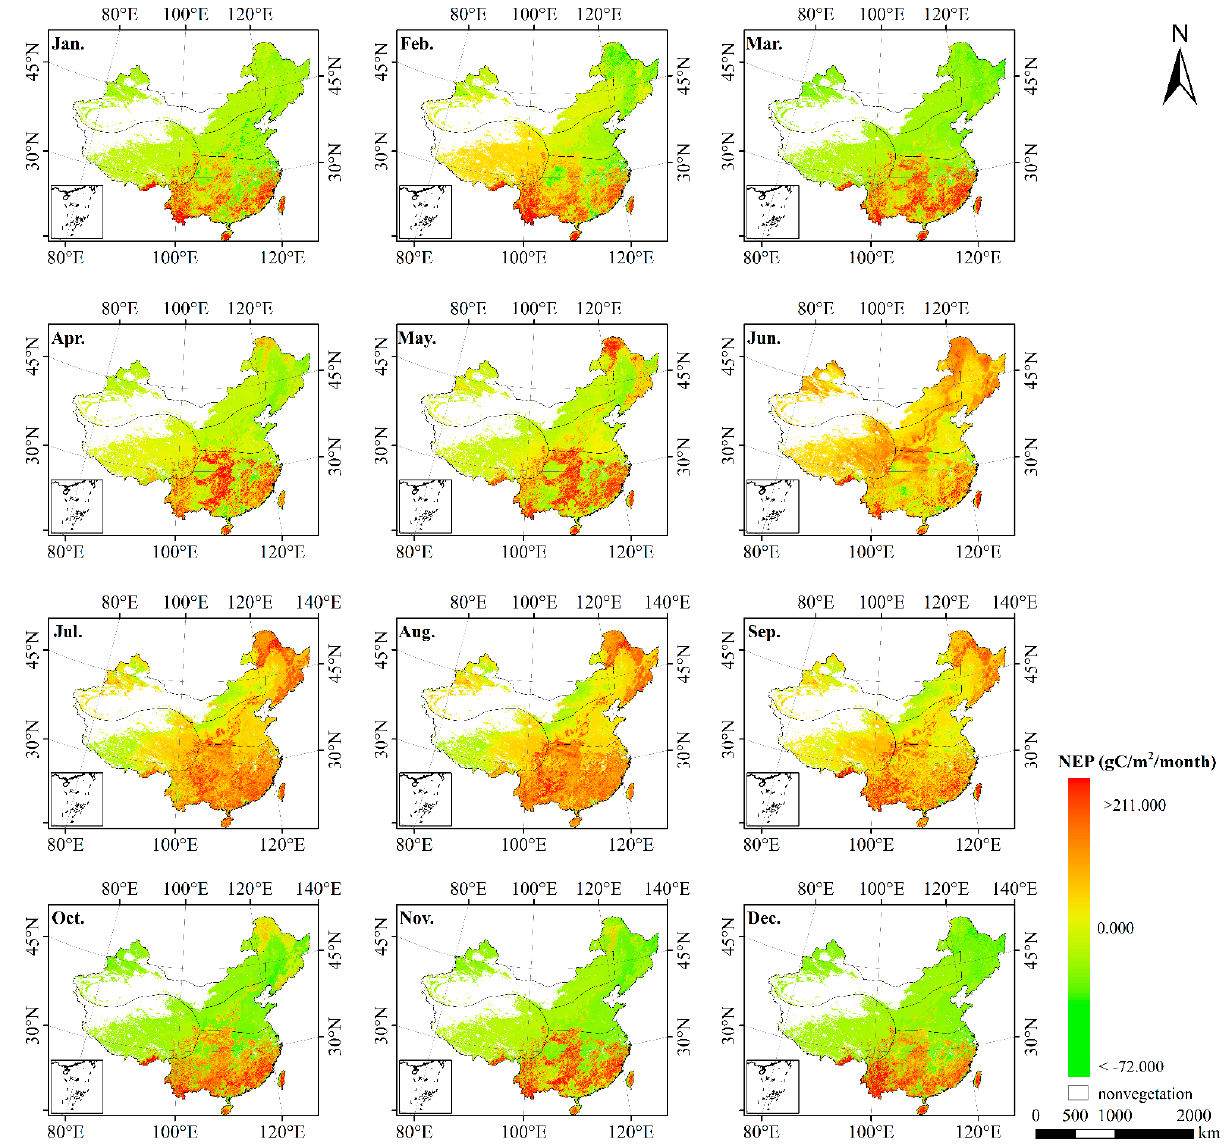
Figure 5. Spatial pattern of monthly NEP estimated over China during 2010 (from January to June) by the CASA model and GSMSR